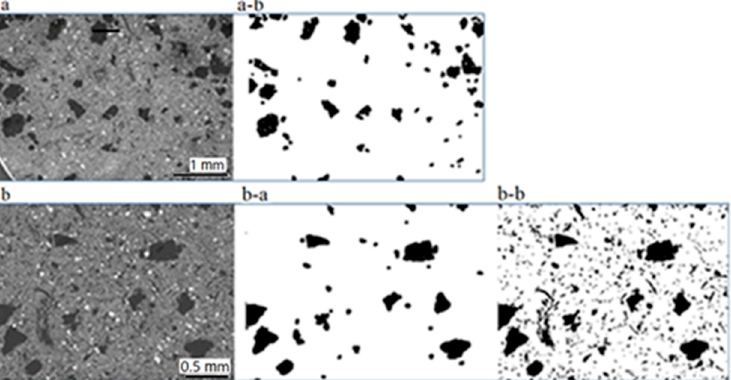
Figure 9. SEM ( a , b ) and binarized images ( a-b , b-a , b-b ) used for the calculation of the carbonaceous particle percentages: Considering particles 0.5 – 0.1 mm ( a-b ), ( b-a ), resulting percentage is 8%; including sizes down to ca. 20 µm ( b-b ), resulting percentage is 15.5%.